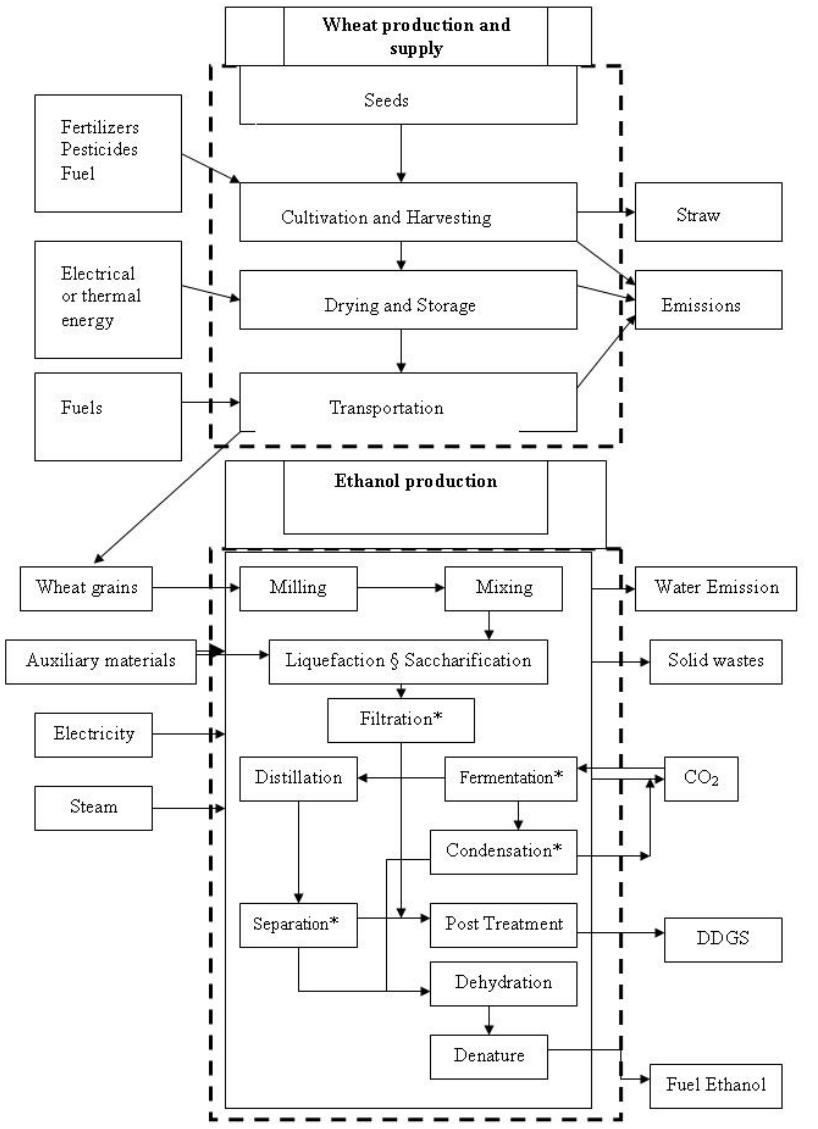
Figure 1. Production pathways for bio-ethanol with Blenke cascade system for Scenario